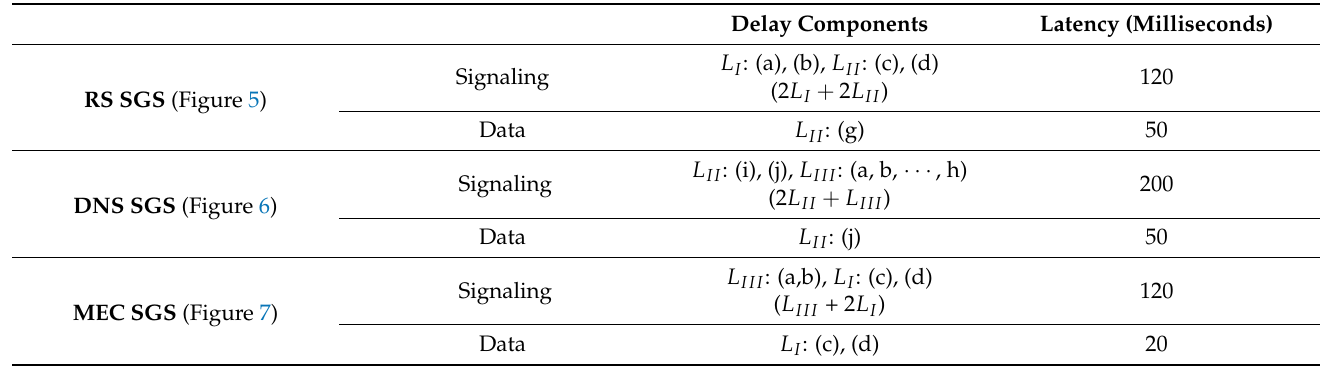
Table 4. Latency